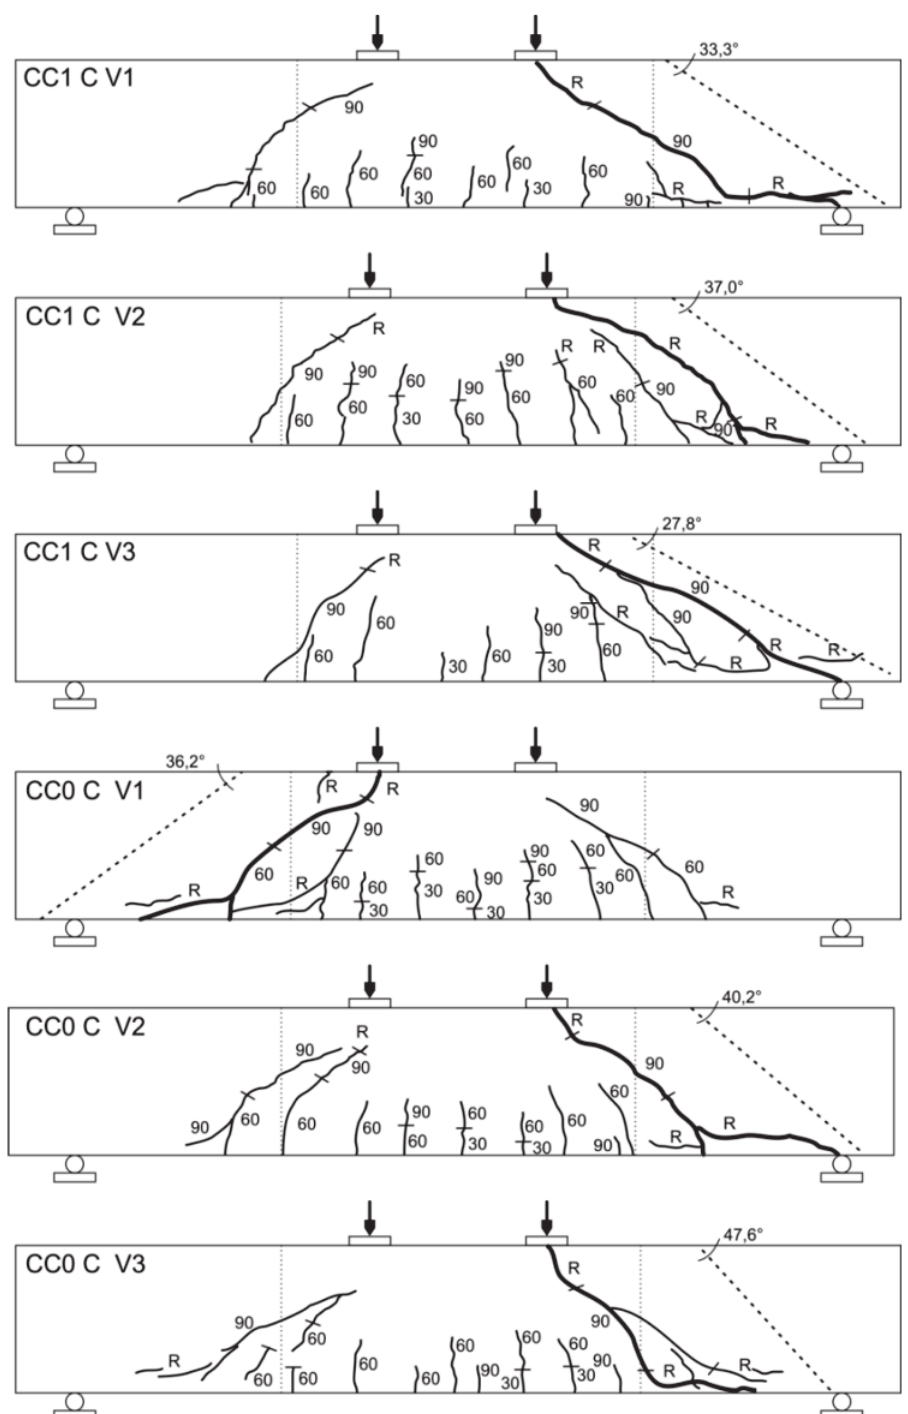
Figure 4 Crack patterns of conventional concrete